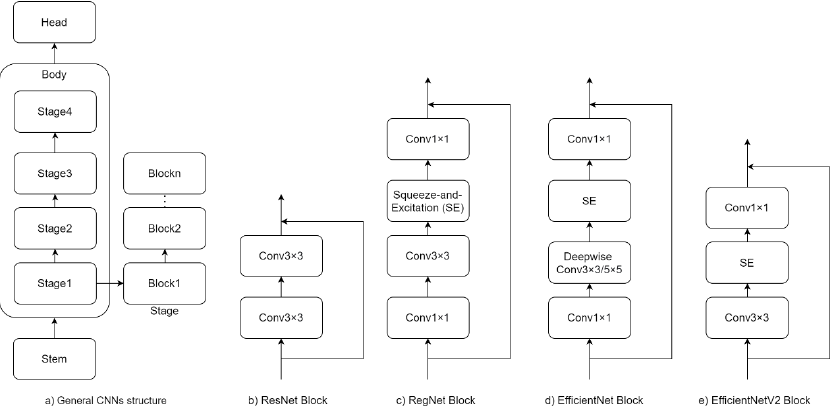
Figure 6. General network structure and detailed block structure for CNN